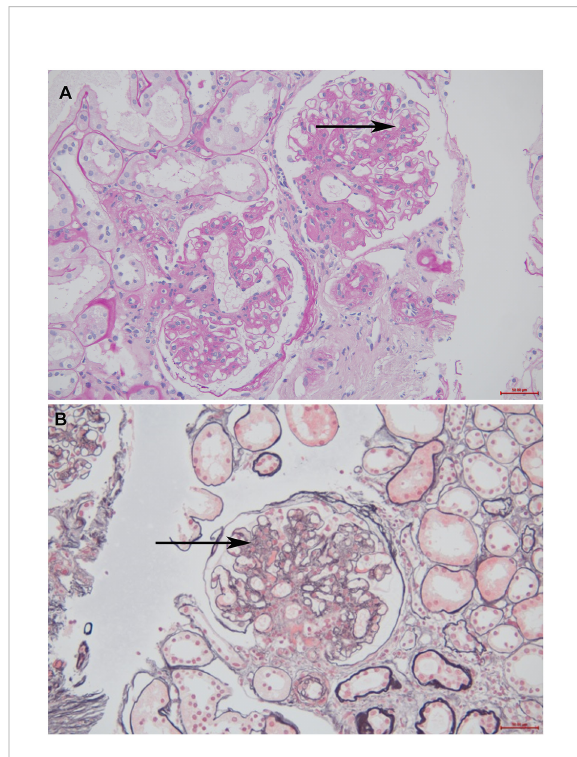
FIGURE 1 The optical microscope results of the patient. (A) Periodic acid- Schiff staining (200× magni fi cation). The black arrow indicates moderate to diffuse proliferation of mesangial cells and stroma (B) Periodic acid silver methenamine staining and Masson ’ s staining (200× magni fi cation). The black arrow indicates severe diffuse proliferation of mesangial cells and stroma.